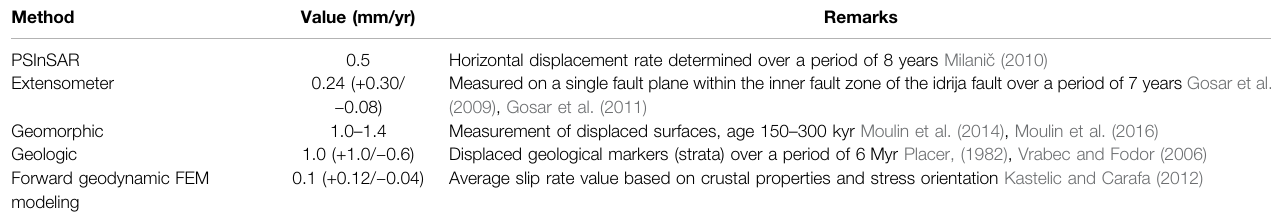
TABLE 3 | Available slip rate data for the Idrija fault.